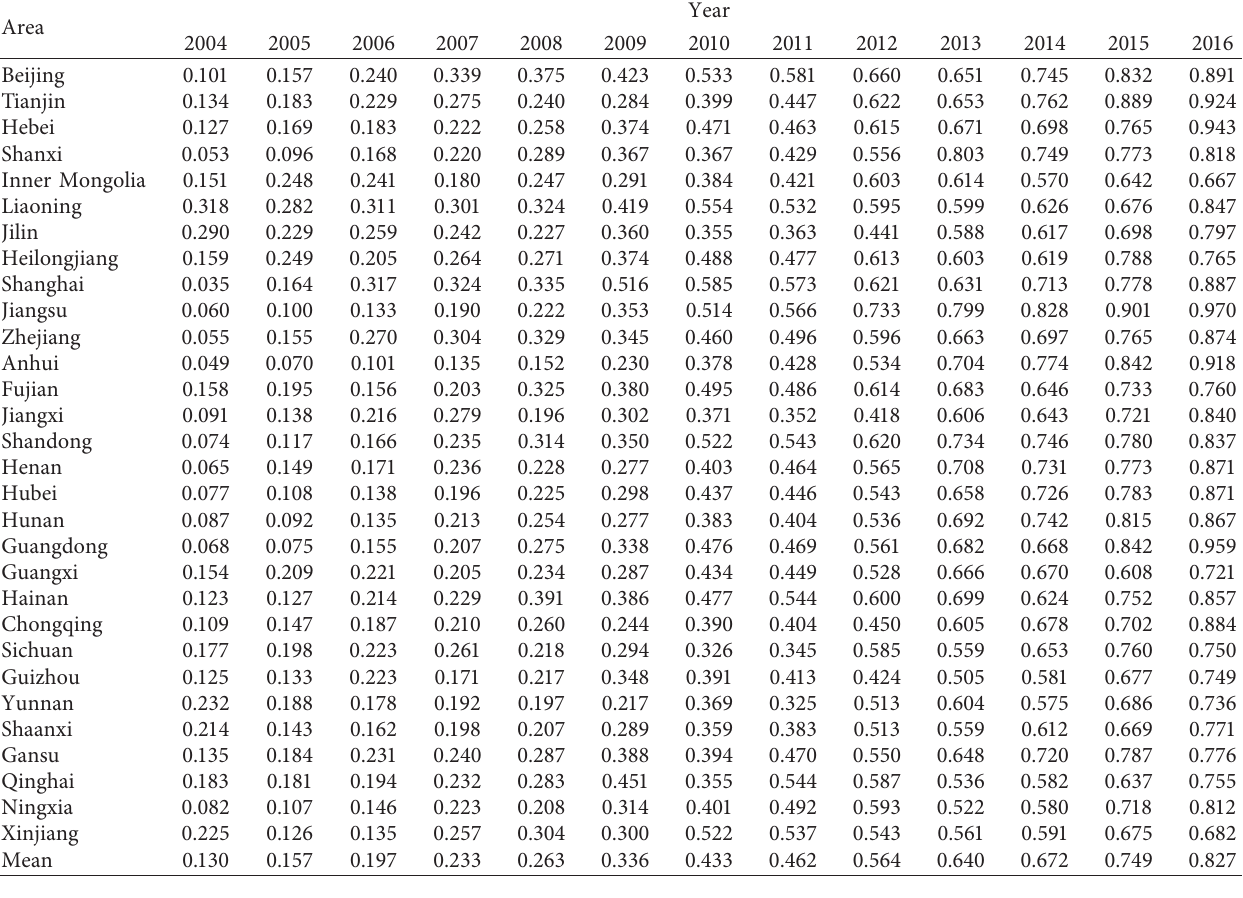
Table 2: Comprehensive level of technological innovation in 30 provinces.